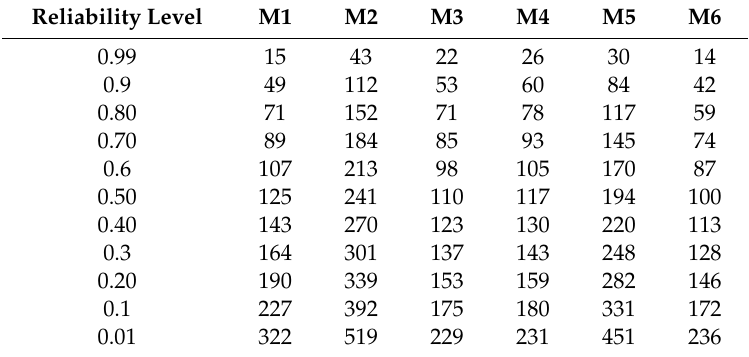
Table 5. Impact strength (number of blows) values corresponding to the defined reliability